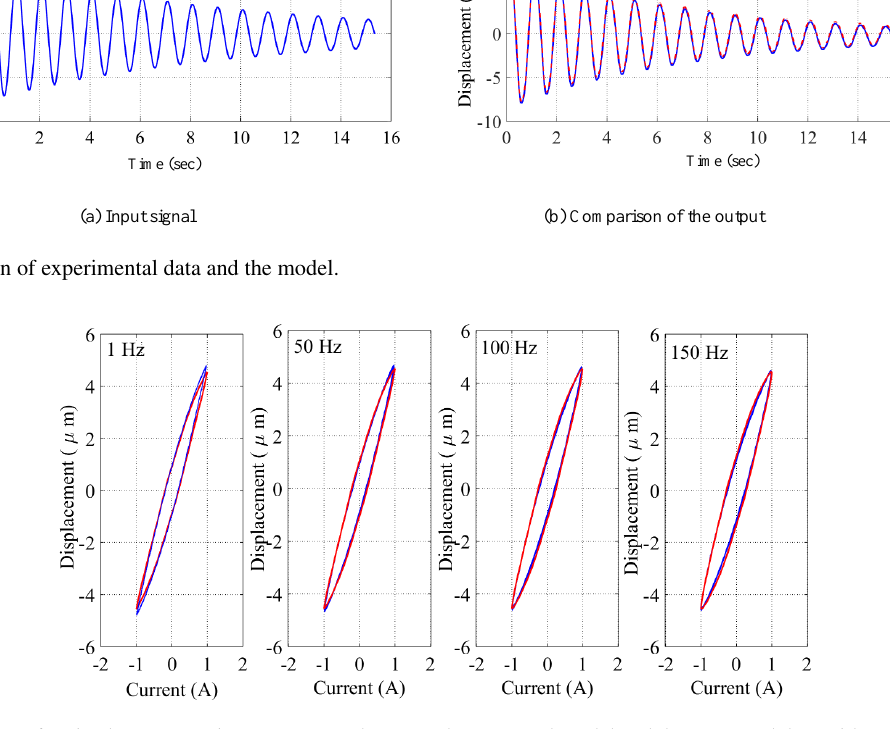
Figure 8. Comparisons of major-loop output-input responses between the proposed model and the measured data without load. (Frequencies in 1, 50, 100 and 150Hz and excitation amplitude 1A, blue line – measured data; red line – proposed model.)